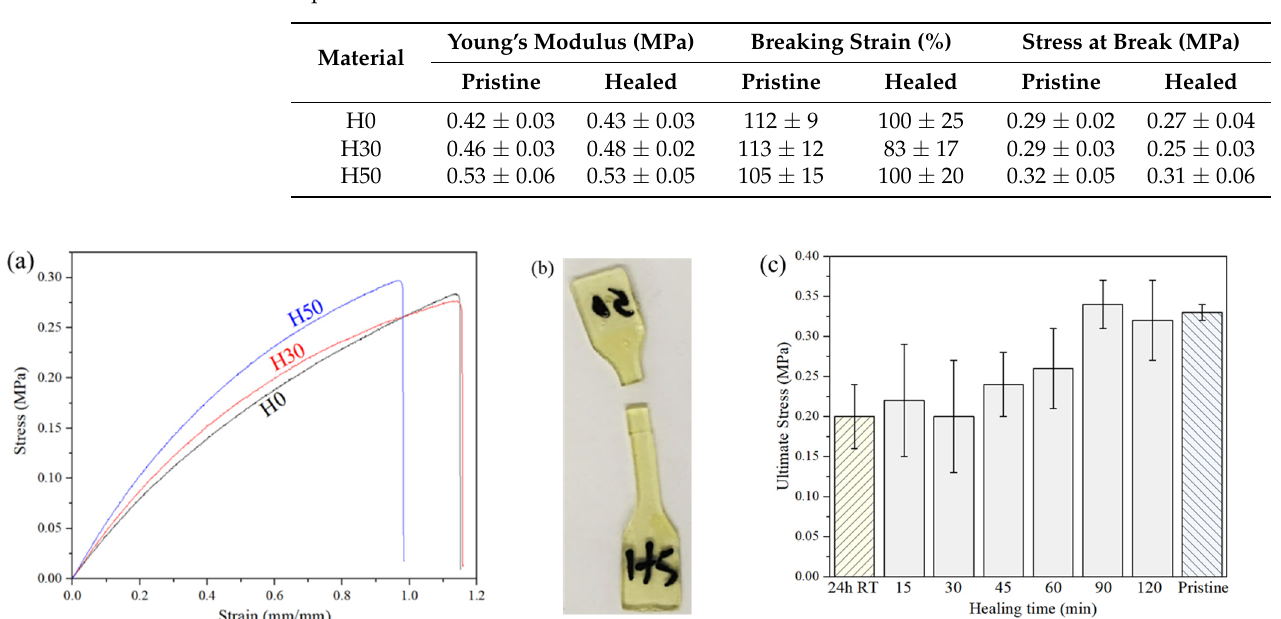
Figure 7. ( a ) Stress-Strain curves of pristine H0, H30 and H50 samples, ( b ) photograph of a H50 tensile sample where fracture occurred at a different place than original wound, ( c ) measured stress at break for wounded H50 samples after different healing times at 75 °C or 24 h at room temperature. Table 3. Tensile tests result for H0, H30 and H50 after 2 h at 75 °C, without and with prior complete separation. Material